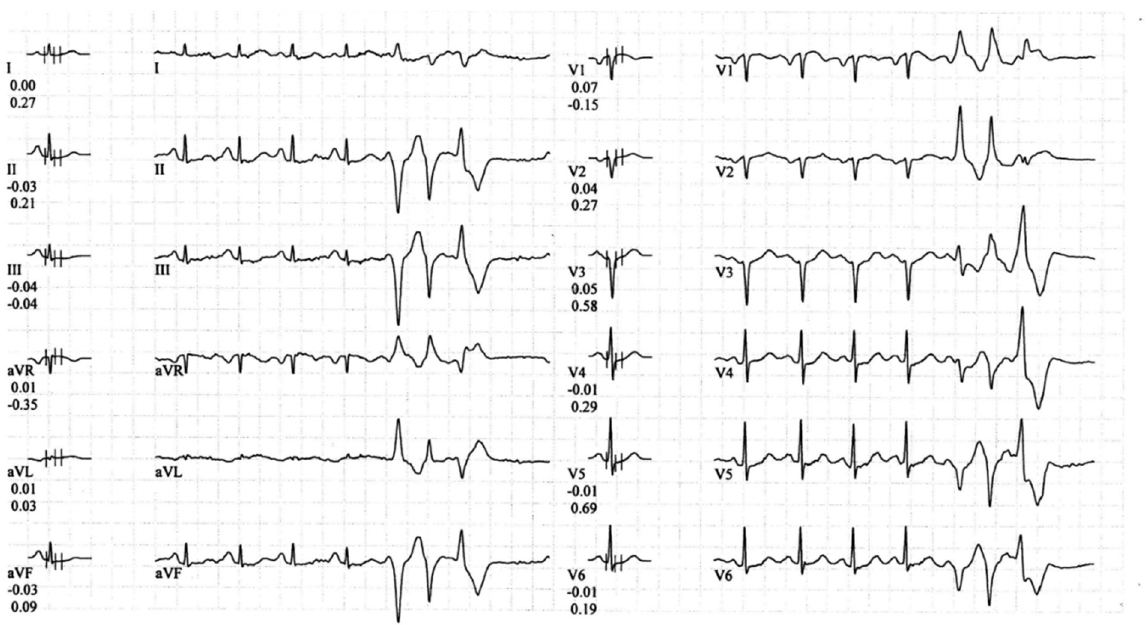
Figure 1. Polymorphic NSVT recorded during the stress test performed by one of the probands in our case (D.M.).